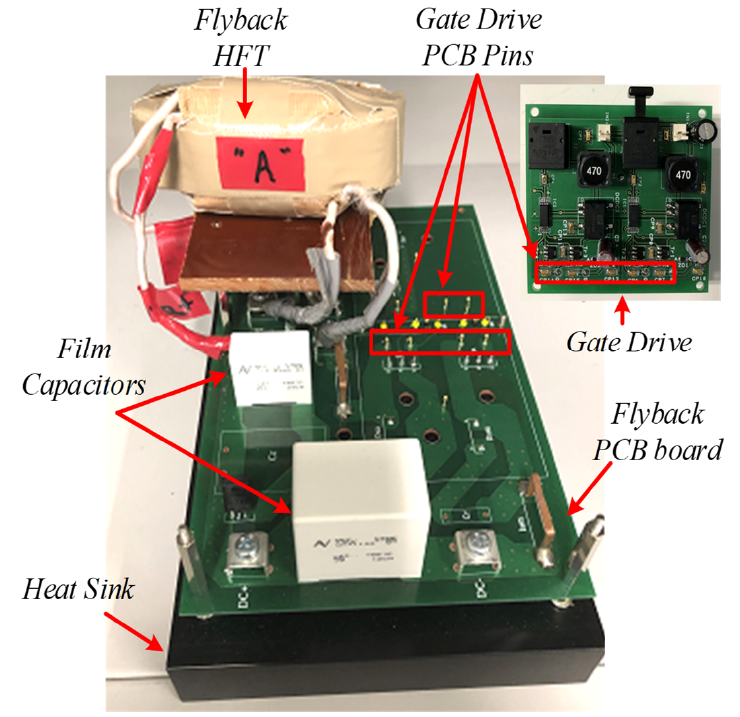
Figure 9. PCB board of a flyback converter module.